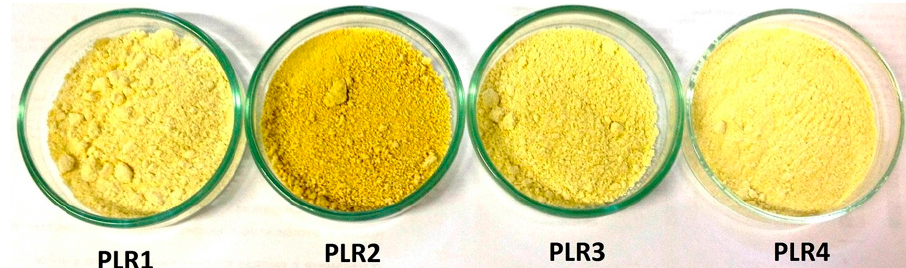
Figure 2. Appearance of spray-dried formulations.